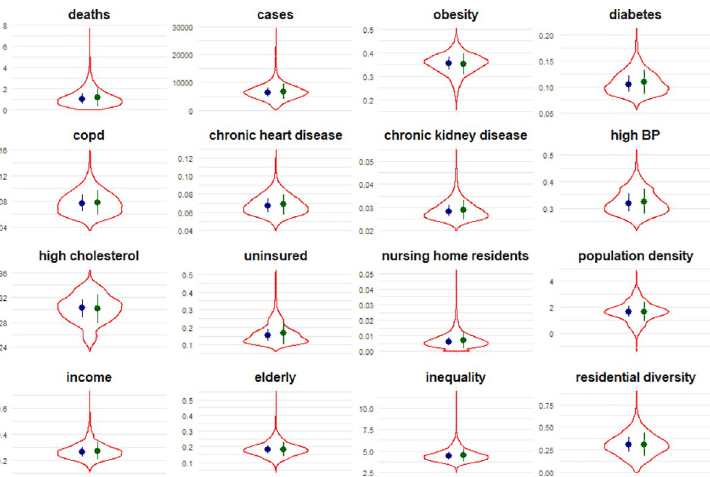
Fig 1. Violin plots of distribution for each variable among counties in the US, along with median (interquartile range) in blue and mean (standard deviation) in green.